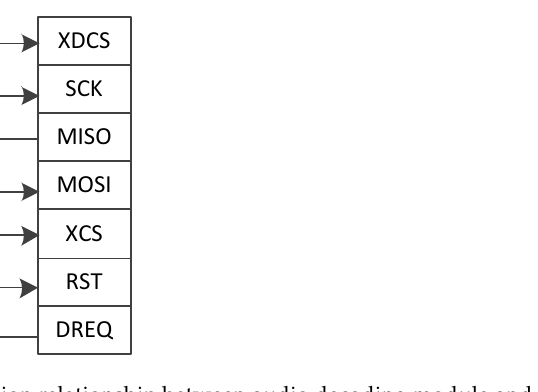
Figure 21. Connection relationship between audio decoding module and main control chip pin.